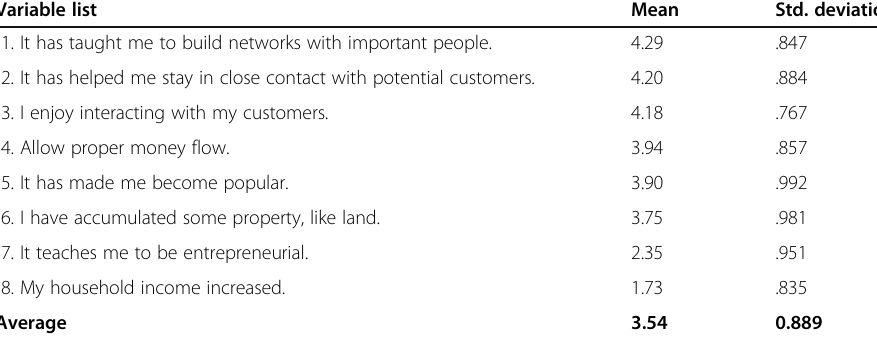
Table 5 Contribution to the growth of